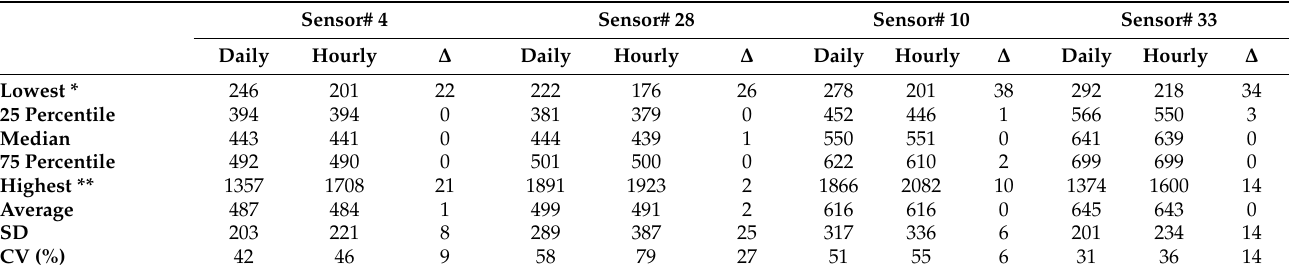
Table 1. Change (relative to the hourly value) in salt concentration statistics (ppm) when values were averaged to hourly and daily from 15 min interval.